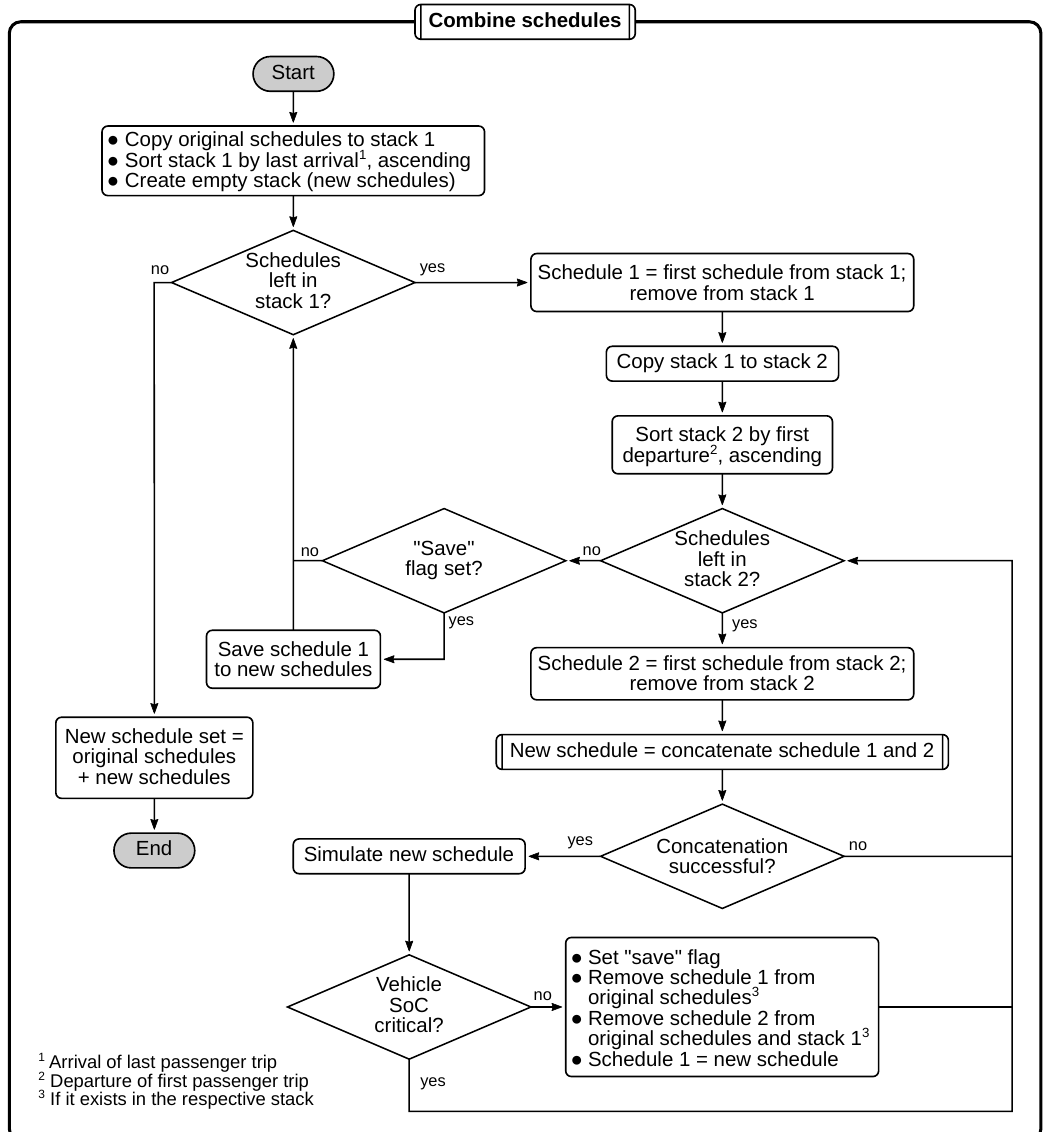
Figure A2. Scheduling algorithm, stage